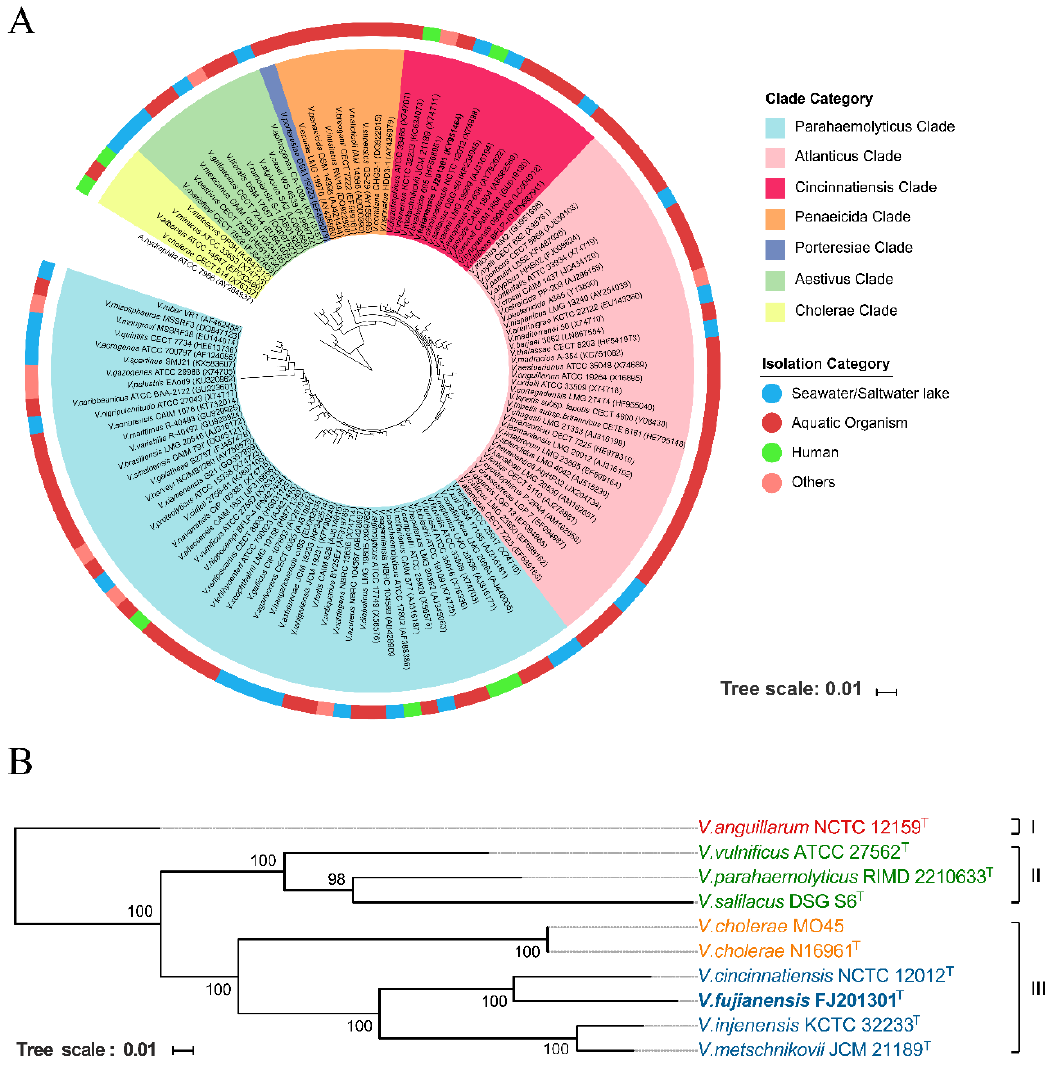
Figure 1. Phylogenetic analysis of Vibrio fujianensis . ( A ) Phylogenetic tree among the genus Vibrio based on 16S rRNA gene sequences. ( B ) Phylogenetic tree based on homologous gene sequences of Vibrio species analyzed in this study. All single-copy homologous genes for each species were concatenated to form a new sequence 97,365 bp in length. The horizonal bar represents 0.01 substitution per nucleotide site. The accession numbers of 16S rRNA gene sequences and genomes are shown in Tables S1 and S2,